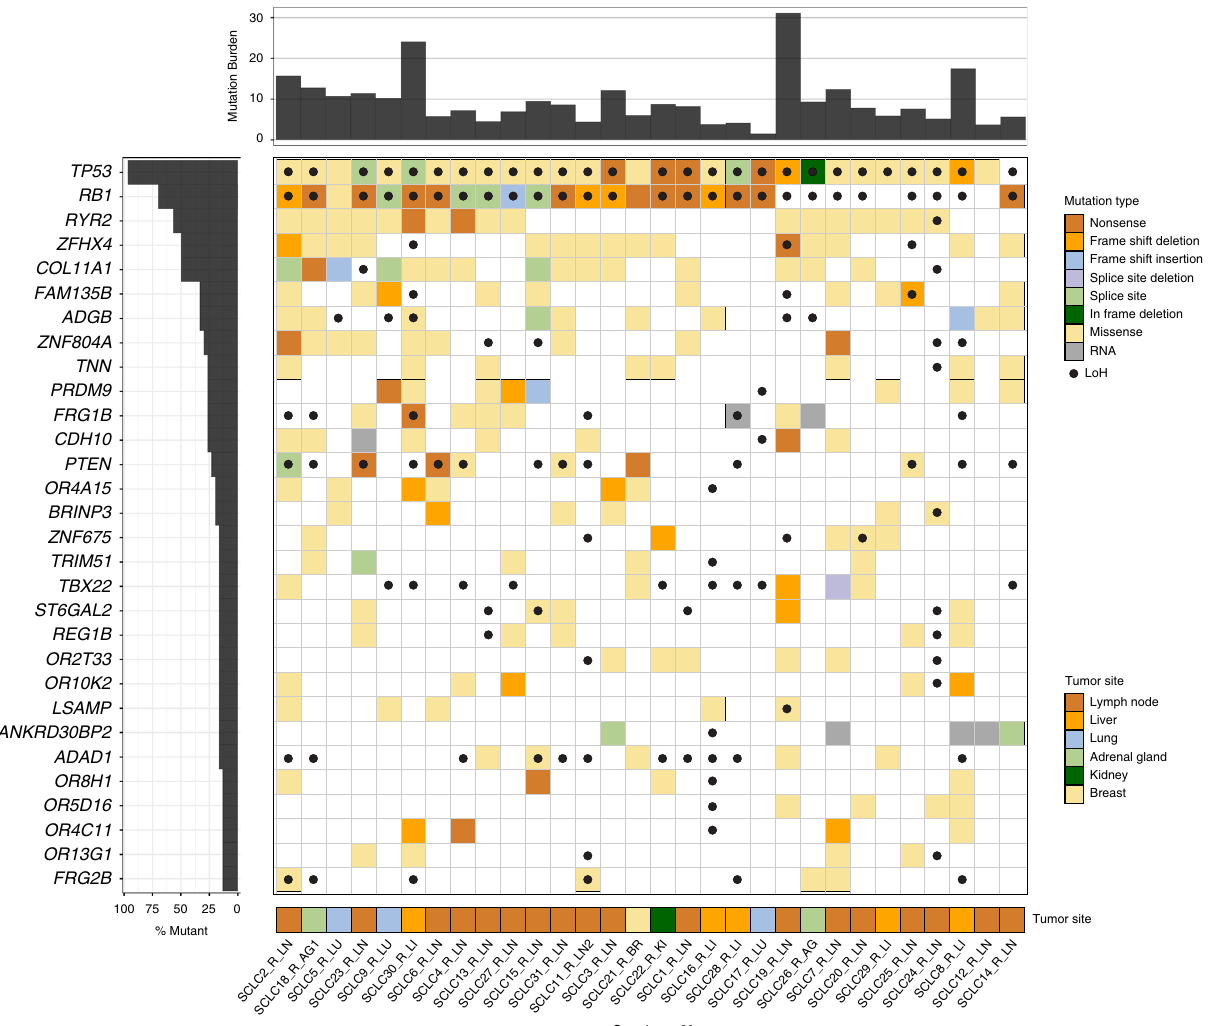
Fig. 1 Signi fi cantly mutated genes in relapsed SCLC. Mutation burdens (mutations/mega-base pair) are displayed on the x -axis panel (top), and cohort mutation percentage by gene is displayed on the y -axis panel (left). Displayed genes are signi fi cantly mutated in relapsed SCLC compared to background mutation rates (FDR < 0.1). Each column represents an individual sample (listed at bottom). Coloring of patient-gene intersection grid denotes mutation type (top legend, center panel) and tumor site (bottom legend, bottom panel). Black dots on sample-gene squares indicate loss of heterozygosity (LoH) of that gene in that sample. TN treatment-naive, R relapsed, LN lymph node, AG adrenal gland, LU lung, BR breast, KI kidney, LI